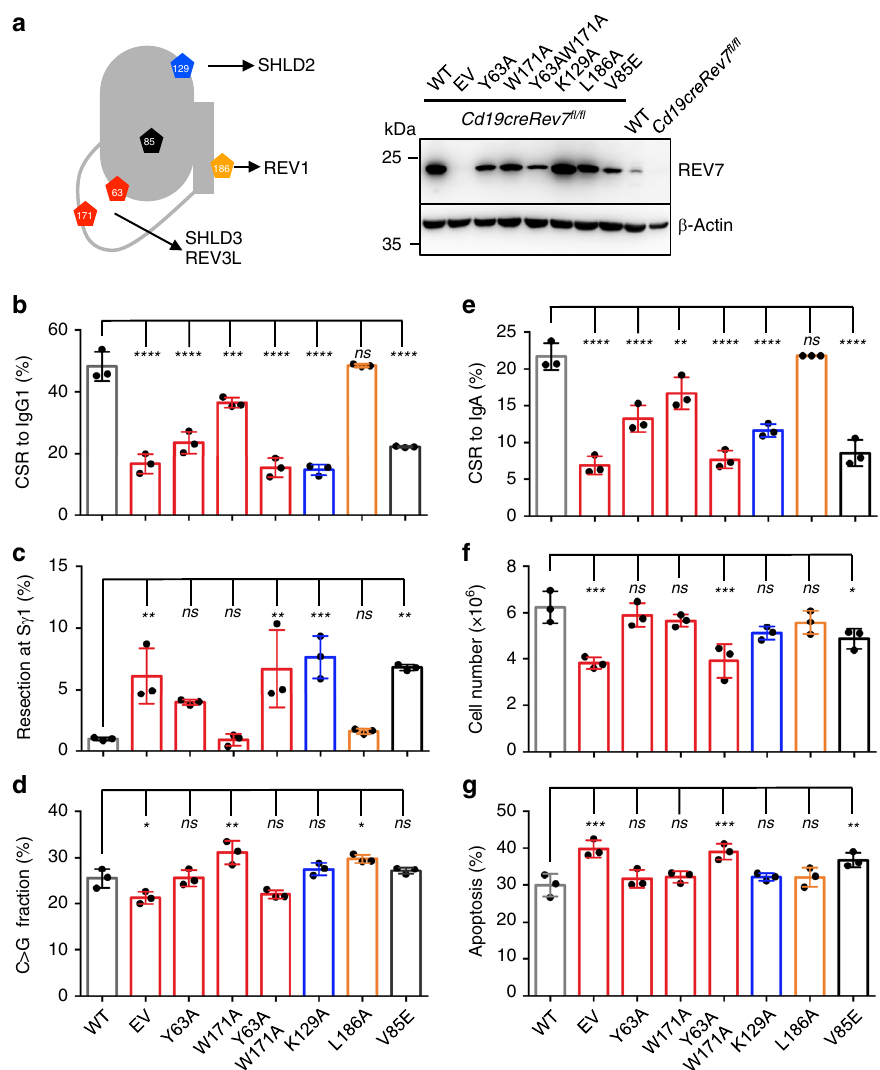
Fig. 3 REV7 HORMA domain is required for B cell survival upon AID expression. a Schematic illustration of critical residues on REV7 protein (left). Representative western blot of REV7 mutant proteins in B cells from three replicates are shown at right. EV: empty vector control. CSR levels to IgG1 ( b ), end resection level in S γ 1 region ( c ), and percentage of C > G transversion in 5 ′ S μ region ( d ) after LPS/IL4 stimulation at Day 4 of REV7-complementated primary B cells. CSR levels to IgA ( e ), cell numbers ( f ), and percentage of apoptotic population ( g ) of indicated CH12F3 cells with cytokine stimulation (CIT) at Day 3 are shown. n = 3 for each genotype in b – g and n represents independent experiments. Data are represented as mean ± SD, one-way ANOVA followed by Dunnett ’ s multiple comparisons test was performed for b – g . Data from cells complemented with WT REV7 protein are used as reference group in comparison. **** p < 0.0001, *** p < 0.001, ** p < 0.01, * p < 0.05, ns: p > 0.05. P -values and sample sizes are provided in Supplementary Table 2. Source data are provided as a Source Data fi